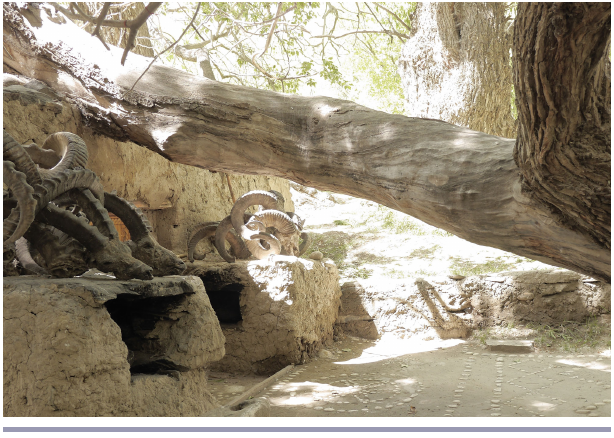
Fig. 2 . Wildlife skulls resting in Mazori Shohkambari Shrine in Langar village of Ishkashim region of